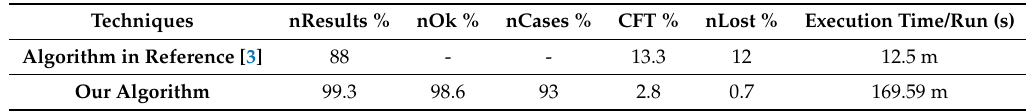
Table 1. Comparison of Track retention statistics for proposed algorithm and algorithm in Reference [3] for OOSM in cluttered